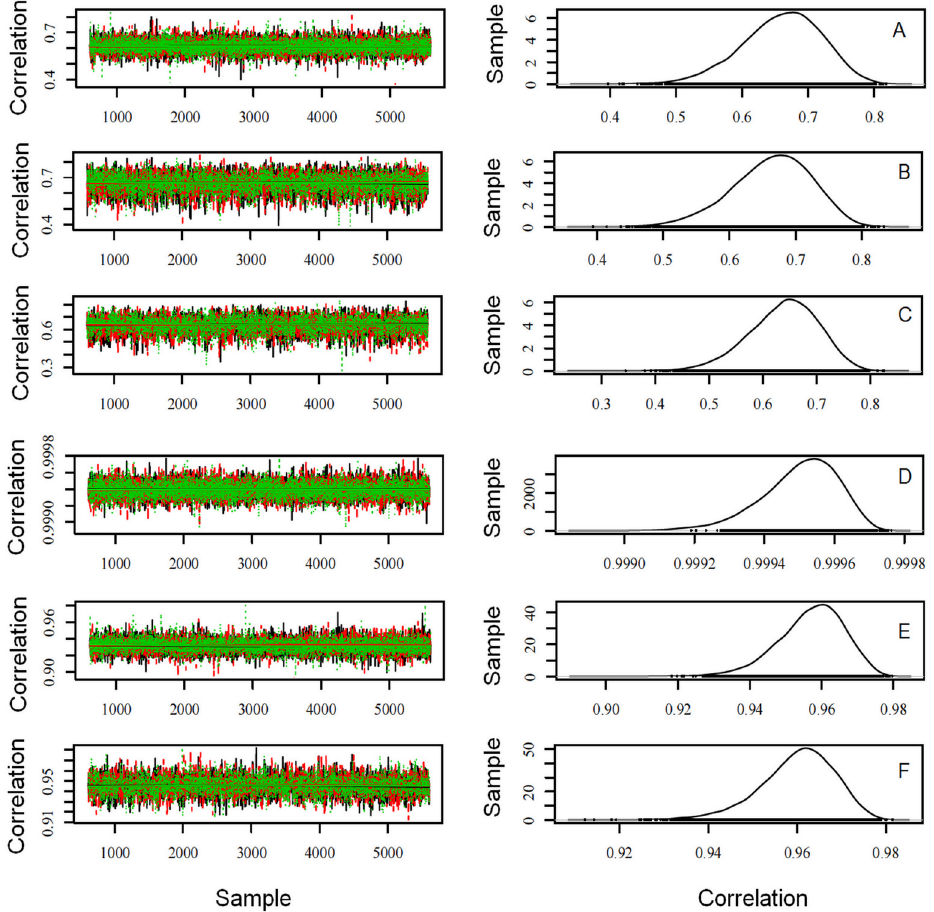
Fig 4. Estimates of correlation between indices pSI-LD1 (A), pSI-PC1 (B), pSI-gSI (C), LD1-PC1 (D), LD1-gSI (E) and PC1-gSI (F). pSI: Selection Index proposed by [13]; gSI: Selection Index proposed by [14]; LD1: first linear discriminant function; and PC1: first principal